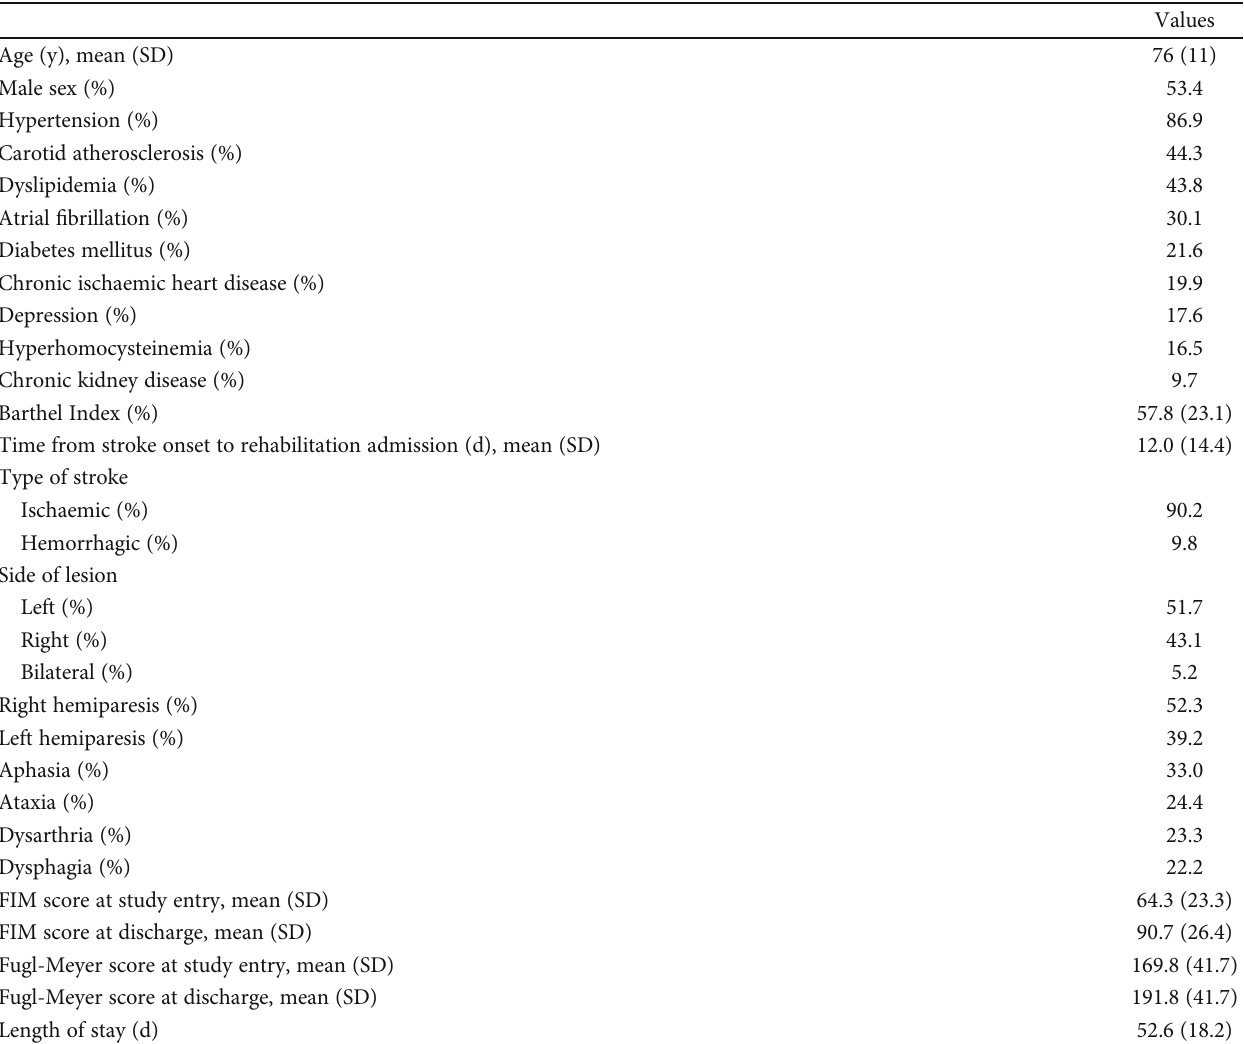
Table 1: Baseline characteristics of the population study.